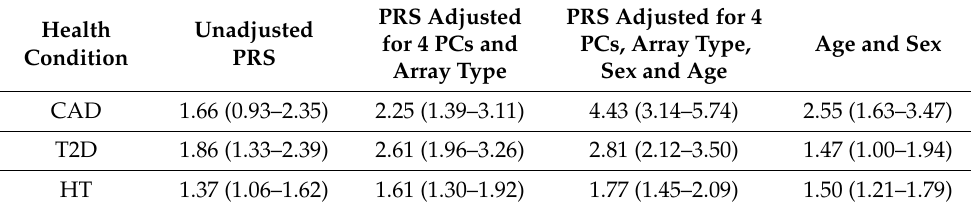
Table 2. Risk increase for the individuals at high genetic risk (10th decile), compared to individuals at low genetic risk (1–7th decile) of population. Second and third column show hazard ratios calculated based on a logistic regression model adjusted for the respective variables. In all cases the difference with the remainder of the population was statistically significant ( p -value < E-100).